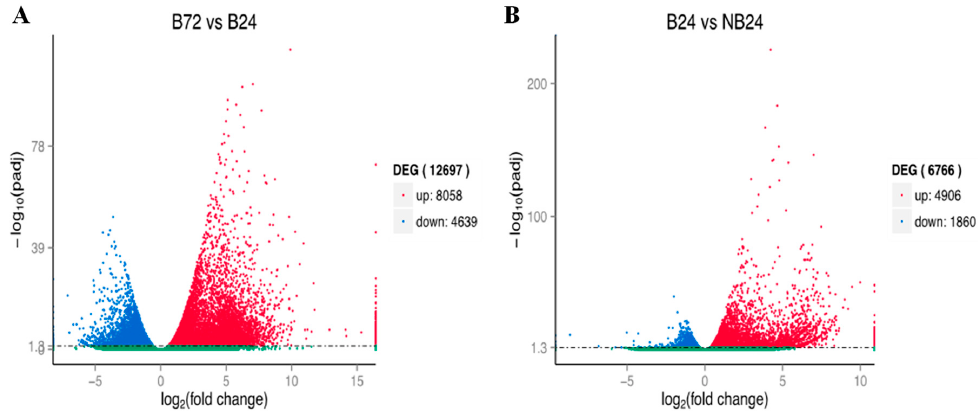
Figure 8. Volcano plots of differentially expressed sequences. (A, the up-regulated or down-regulated (( A ), the up-regulated or genes between B72 and B24; B, the up-regulated or down-regulated genes between NB24 and B24). The down-regulated genes between B72 and B24; ( B ), the up-regulated or down-regulated genes abscissa denotes the expressed fold change of genes in different treatments. The ordinate denotes the between NB24 and B24). The abscissa denotes the expressed fold change of genes in different statistically significant difference degree. Different genes were filtered using padj < 0.05. The scatter treatments. The ordinate denotes the statistically significant difference degree. Different genes were points in the diagram denote each gene, and the green dots indicate there was no significant difference. filtered using padj < 0.05. The scatter points in the diagram denote each gene, and the green dots indicate The red and the blue dots are for up-regulated and down-regulated genes, respectively. there was no significant difference. The red and the blue dots are for up-regulated and down-regulated genes,